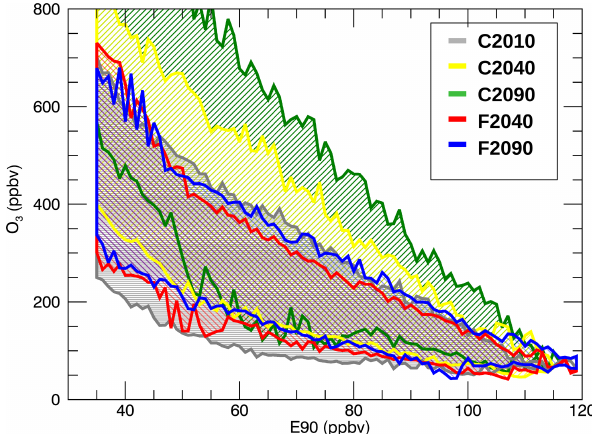
Figure 4. O 3 –E90 correlation in the GLENS mixing layer for today (C2010) and the future scenarios considering both global warming (C2040, C2090) and additional geoengineering (F2040, F2090). An overview of the presented cases is given in Table 1.